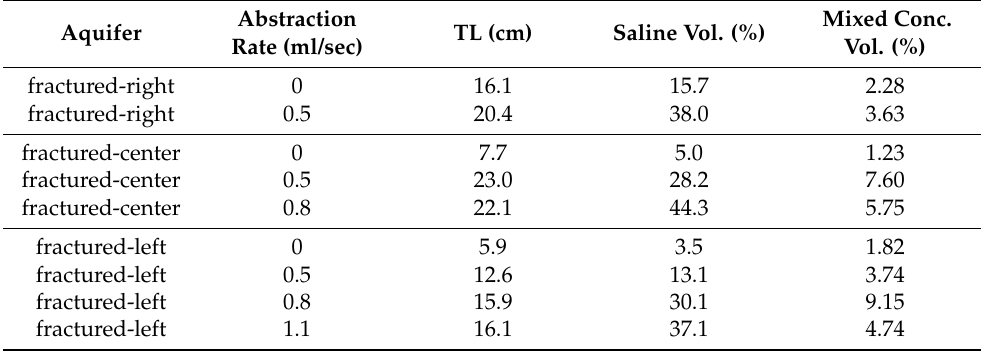
Table 3. Experimental quasi-steady values of TL, saline volume fraction and mixed concentration volume fraction, for the various abstraction rates applied in the three synthetic fractured